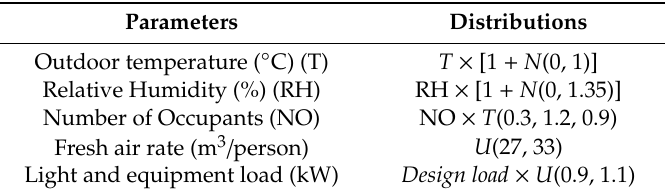
Table 1. Distributions of stochastic input parameters.